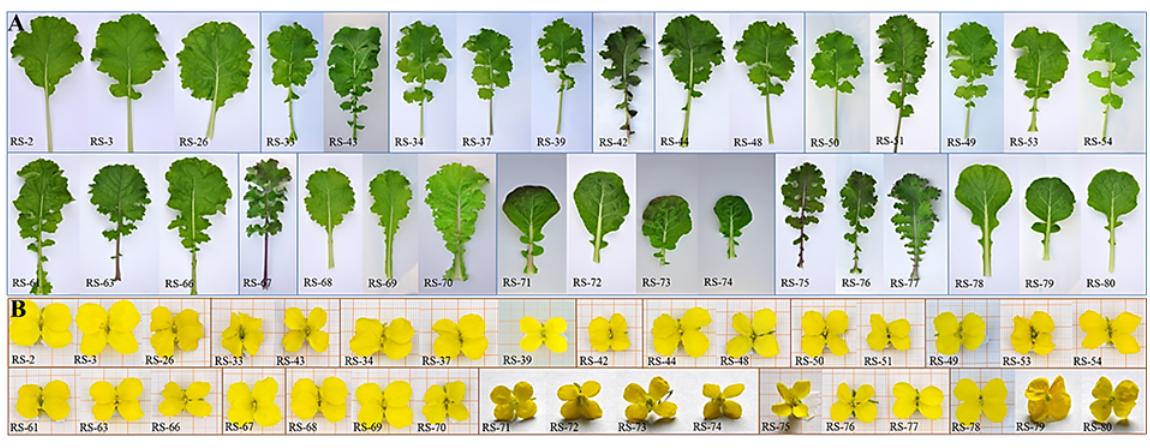
Figure 2 Morphological variation in the leaves ( A ) and flowers ( B ) of different resynthesized (RS) oilseed rape lines: RS-2, RS-3, RS-26 [ Brassica rapa ssp. chinensis var. chinensis (Pak Choy) × Brassica oleracea ssp. acephala var. sabellica ‘Halbhoher Grüner’]; RS-33, RS-43 [ Brassica rapa ssp. oleifera ‘Skye’ (spring type) × Brassica oleracea ssp. acephala var. sabellica ‘Halbhoher Grüner’]; RS-34, RS-37, RS-39 [ Brassica rapa ssp. oleifera ‘Kova’ (spring type) × Brassica oleracea ssp. acephala var. sabellica ‘Halbhoher Grüner’]; RS-42 [ Brassica oleracea ssp. acephala var. sabellica ‘Halbhoher Grüner’ × Brassica rapa ssp. oleifera ‘Skye’ (spring type); RS-44, RS-48 [ Brassica oleracea ssp. acephala var. sabellica ‘Vitessa’ × Brassica rapa ssp. oleifera ‘Ludowy’ (winter type)]; RS-50, RS-51 [ Brassica oleracea ssp. acephala var. sabellica ‘Vitessa’ × Brassica rapa ssp. oleifera ‘Kova’ (spring type)]; RS-49, RS-53, RS-54 [ Brassica oleracea ssp. acephala var. sabellica ‘Vitessa’ × Brassica rapa ssp. oleifera ‘Skye’ (spring type)]; RS-61, RS-63, RS-66 [ Brassica oleracea ssp. acephala var. sabellica ‘Vitessa’ × Brassica rapa ssp. oleifera ‘Premium’ (winter type)]; RS-67 [ Brassica rapa ssp. oleifera ‘Salut’ (winter type) × Brassica oleracea ssp. acephala var. sabellica ‘Kapral’]; RS-68, RS-69, RS-70 [ Brassica rapa ssp.